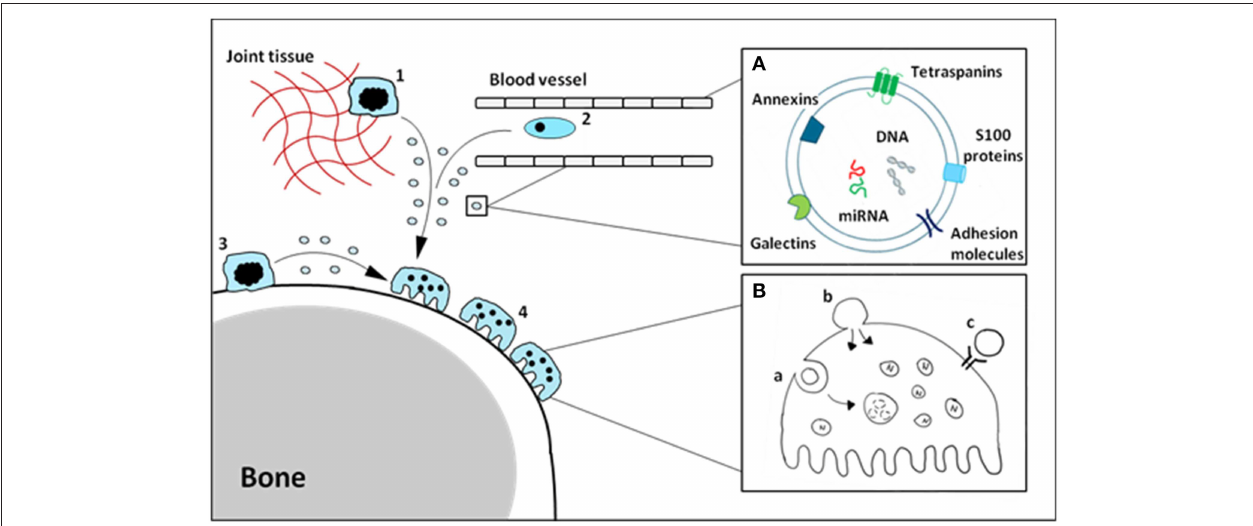
FIGURE 1 | Schematic cartoon of macrophage-derived EVs carrying alarmins impacting osteoclasts. Tissue-resident (1), circulating (2) and osteal macrophages (3) can secrete EVs carrying alarmins (A) . These vesicles can interact with bone cells, including osteoclasts (4), in a number of different ways (B) . Vesicles can be internalized (a), fuse with the cell membrane (b) or ligands present on the outer membrane of the vesicle can interact with receptors on the cellular membrane (c). The composition and relative quantities of alarmins on macrophage-derived EVs will determine their functional effects.